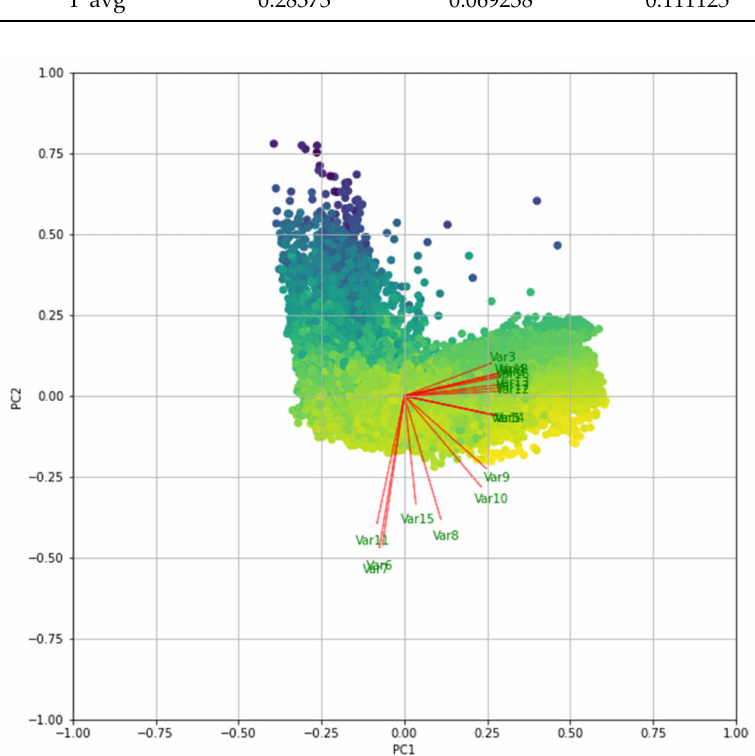
Figure 15. PC1 vs. PC2.